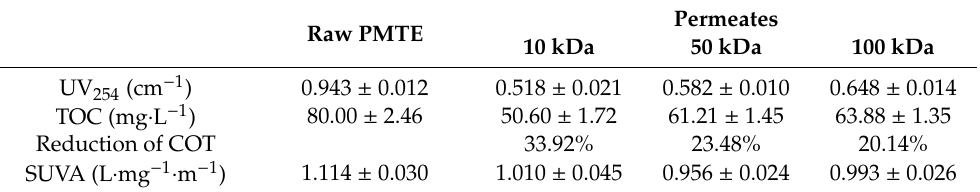
Table 6. Aromatic carbon (SUVA) in the PMTE and permeates, at 2.0 bar and di ff erent MWCO. Raw PMTE